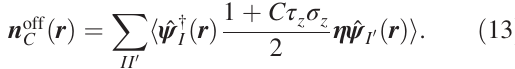
E 1 e skyr and 1 e are